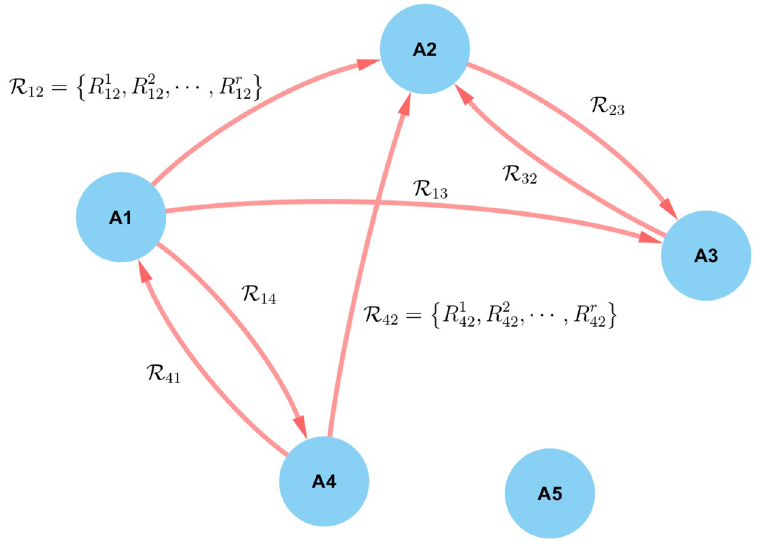
Fig 1. A graphical model of narratives. For a story with a set of actants A 1 , ... , A n , the narrative can be divided into a set of contexts. In each context, the story is summarized as a set of interactions (relationships) between actants as shown in the figure. Therefore, an edge between actants A1 and A2 carries a set of relationships ¼ f R 1 ; R 2 ; ... ; R r g that exist between the two actants, and the significance of each relationship in this context. It R 12 12 12 12 is important to note that relationships come from not only verbs, but also other syntactic structures in the text that imply relationships.